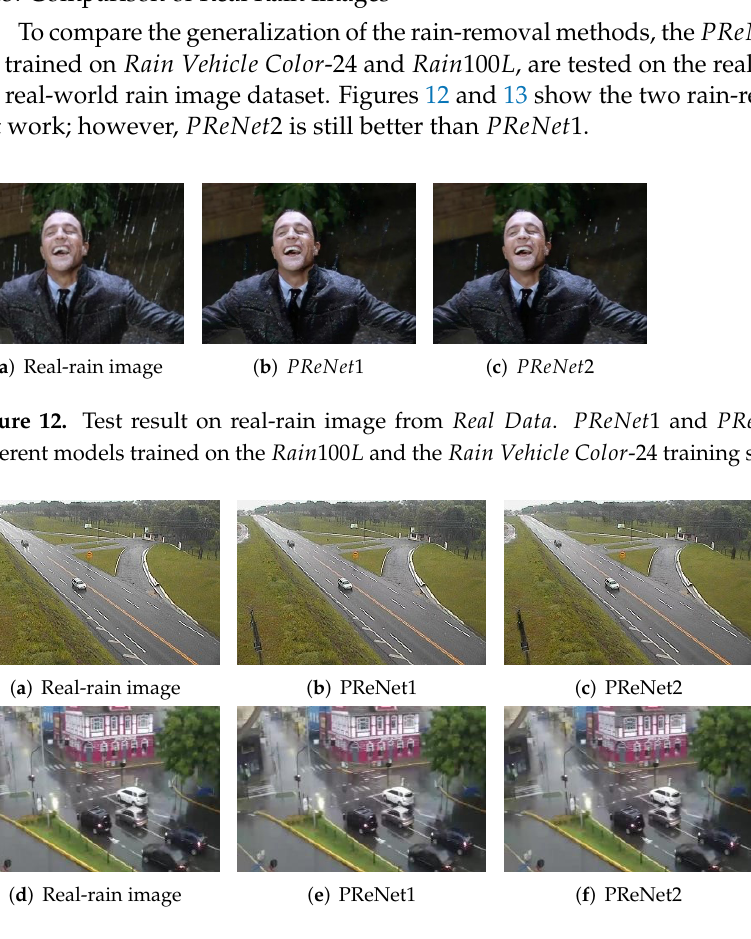
Figure 13. Test results on two real-rain images containing vehicles from RIS . PReNet 1 and PReNet 2 represent the different models trained on Rain 100 L and Rain Vehicle Color -24,